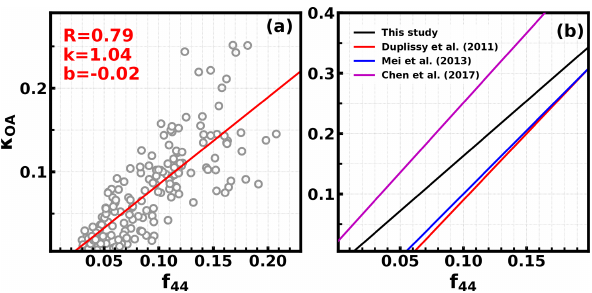
Figure 7. (a) The relationship between derived κ OA and f 44 . (b) Comparison with previous studies.